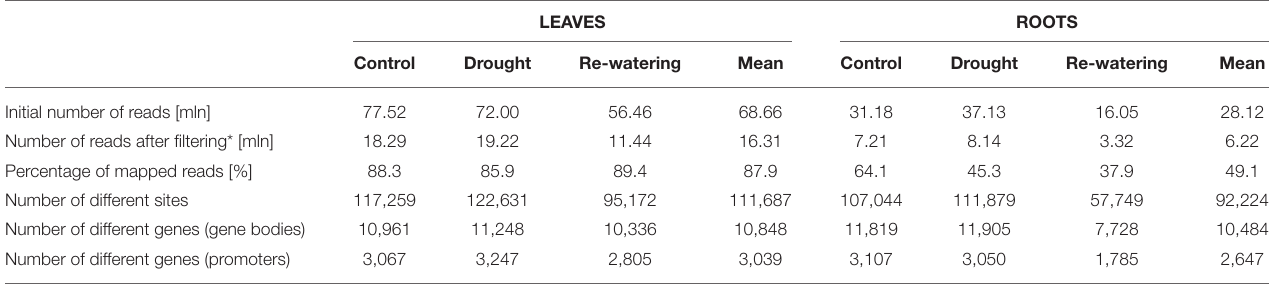
TABLE 3 | The statistics of MSAP-Seq reads during different data processing steps during comparative evaluation of DNA methylation changes in barley leaf and root in response to water deficiency stress. LEAVES ROOTS Control Drought